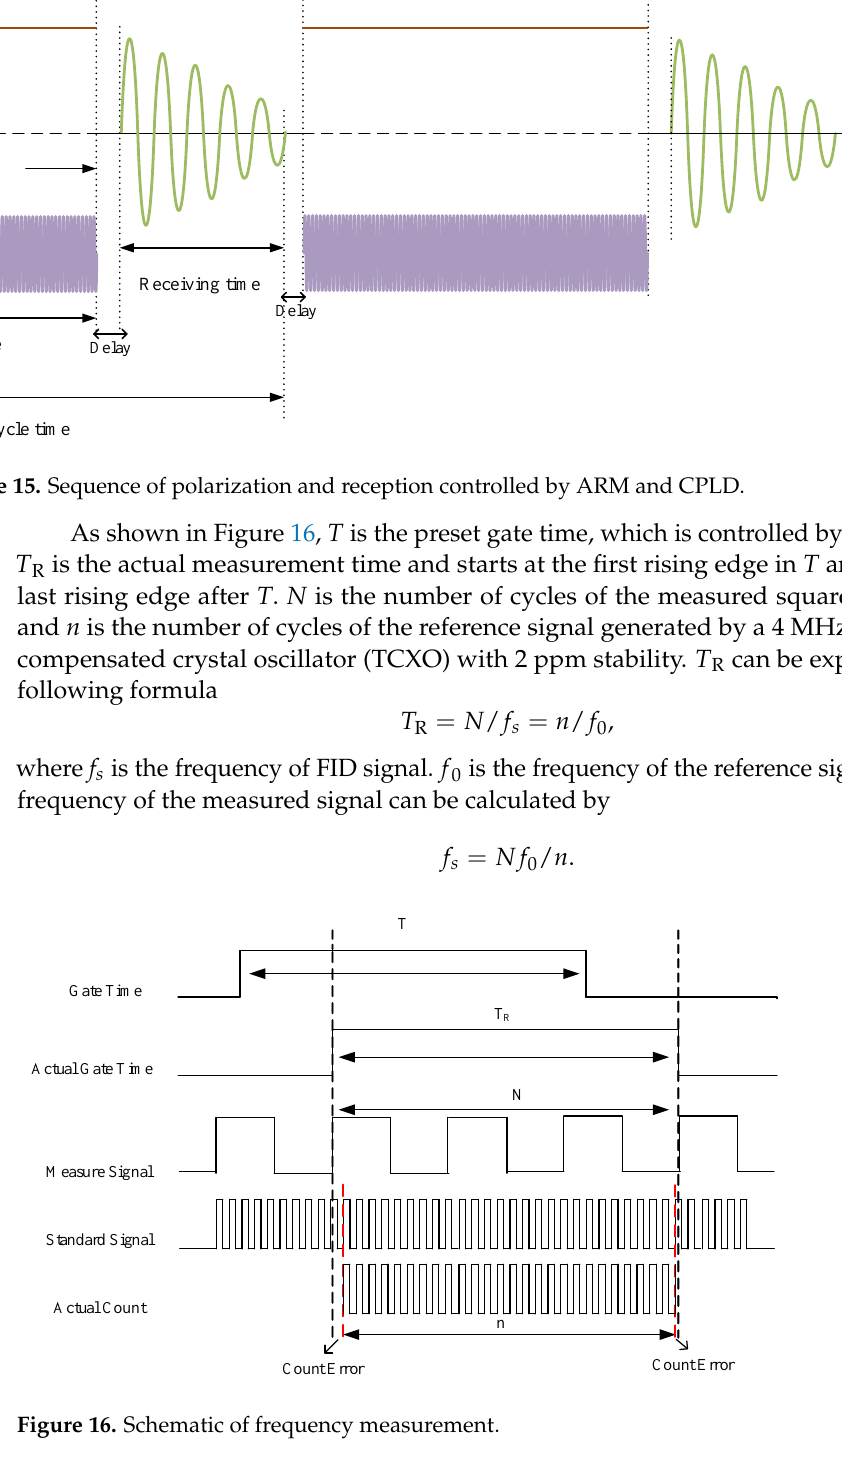
Figure 16. Schematic of frequency measurement. The ± 1 count error of n can be ignored because n much-greater-than N